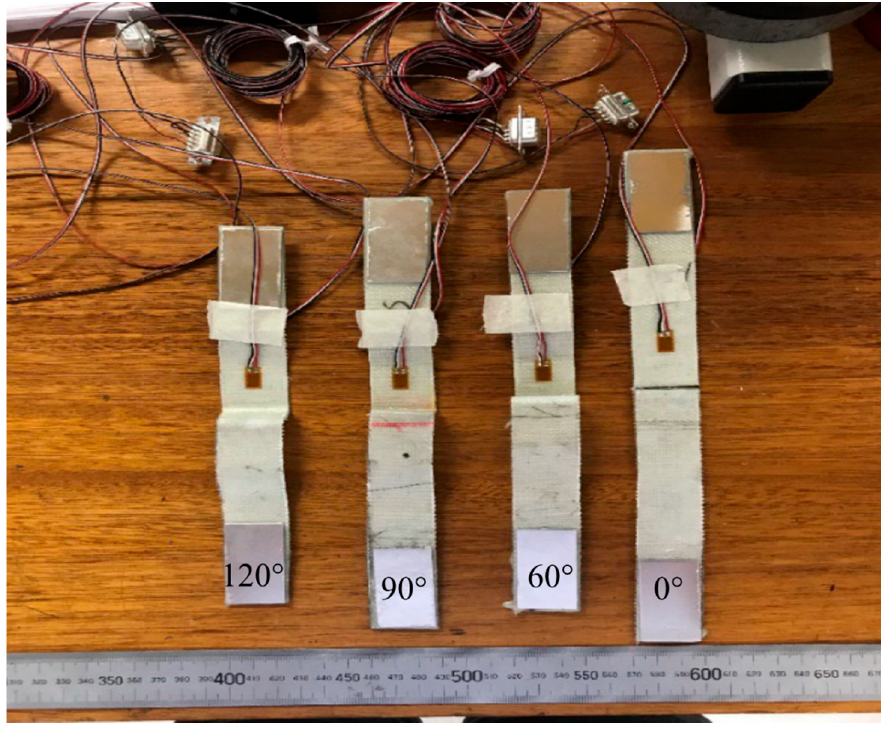
Figure 4. Test specimens with far-field strain gauges attached.